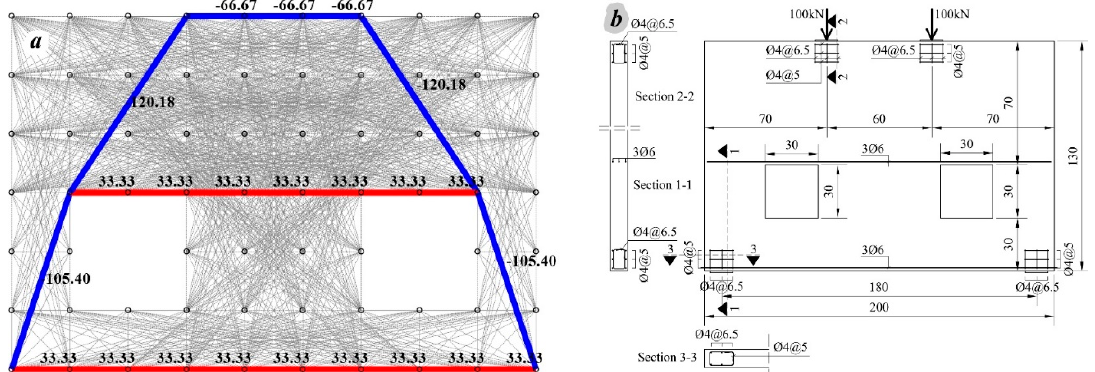
Figure 7. ( a ) Strut-and-Tie model for W2, ( b ) reinforcement layout.